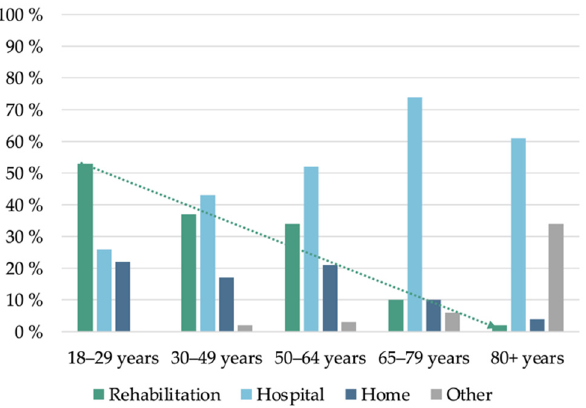
Figure 1. Direct pathway by year for patients with moderate–severe TBI ( n = 873). The percentage of patients following the direct pathway (rehabilitation) increased during the period. “Other” includes general rehabilitation, nursing home and other.